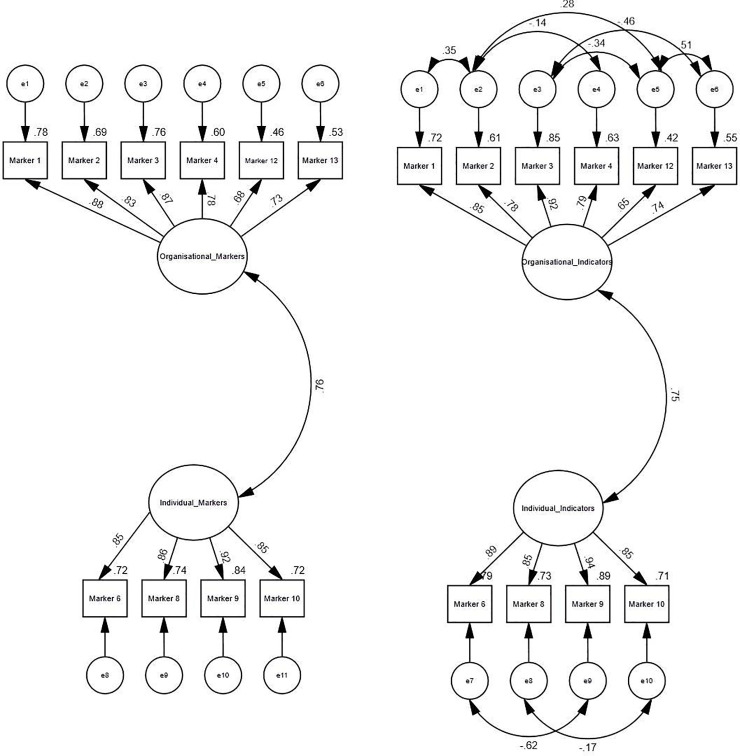
A Initial CFA-model. Notes: Rectangles represent measured items (endogenous variables); circles represent latent (unmeasured/exogenous) variables. Marker 1 (BRC senior leadership roles), Marker 2 (Leadership development), Marker 3 (BRC staff category), Marker 4 (Recruitment and retention), Marker 6 (External grant funding), Marker 8 (Publications e.g. authorship), Marker 9 (Intellectual property), Marker 10 (Collaboration with industry), Marker 12 (Organisational policies on gender equity) and Marker 13 (Organisational Targets for gender equity). B Post-hoc CFA model. Notes: Rectangles represent measured items (endogenous variables); circles represent latent (unmeasured/exogenous) variables. Marker 1 (BRC senior leadership roles), Marker 2 (Leadership development), Marker 3 (BRC staff category), Marker 4 (Recruitment and retention), Marker 6 (External grant funding), Marker 8 (Publications e.g. authorship), Marker 9 (Intellectual property), Marker 10 (Collaboration with industry), Marker 12 (Organisational policies on gender equity) and Marker 13 (Organisational Targets for gender equity).